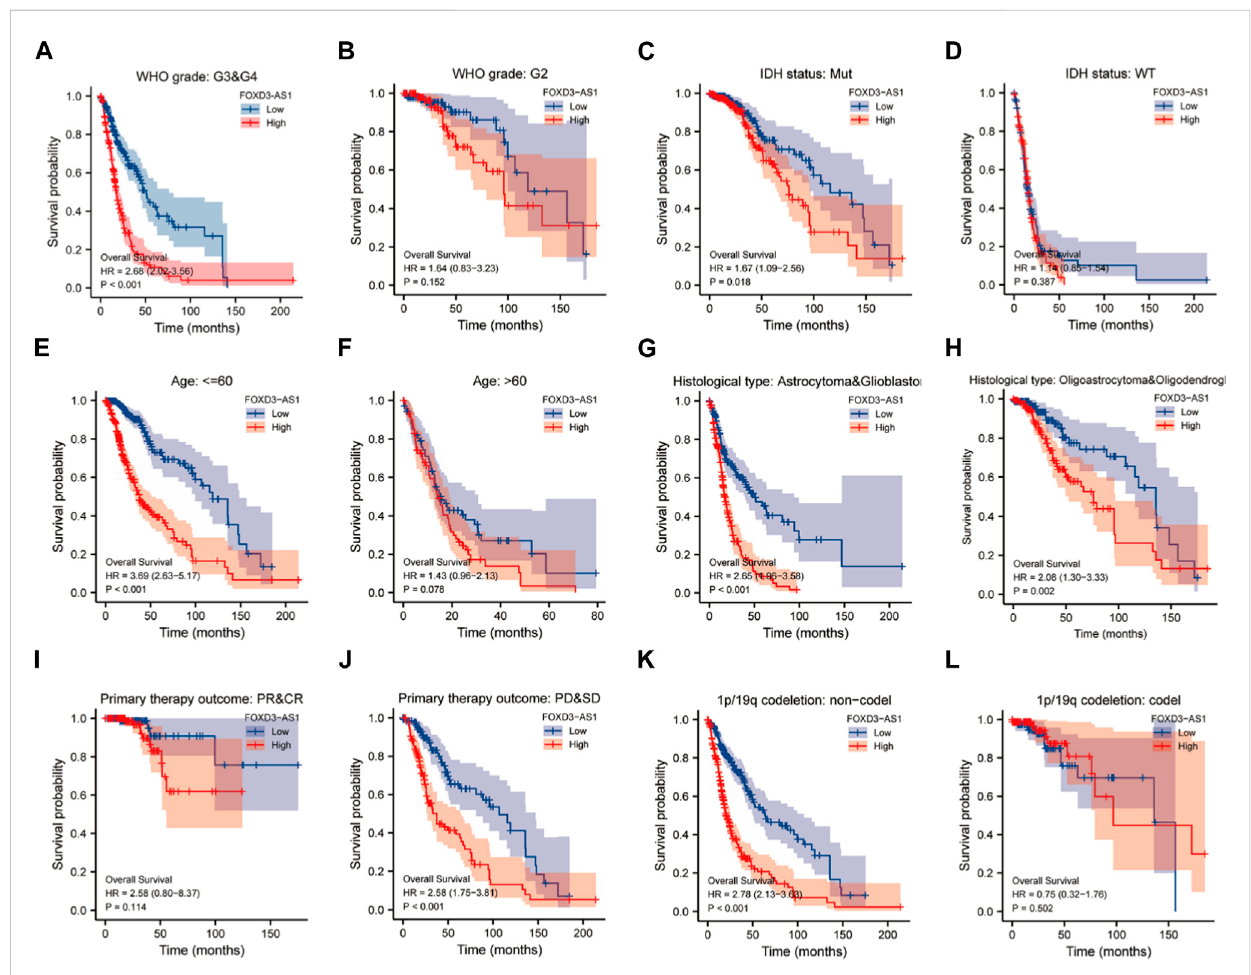
FIGURE 8 PrognosticvalueofKIF4A inEC patients. Kaplan-Meierstrati fi edsurvival analysis ofclinicaladversesubgroups,respectively (A, B) WHO grade, (C, D) IDH status, (E, F) Age, (G, H) Histological type, (I, J) Primary therapy outcome (K, L) 1p/19q